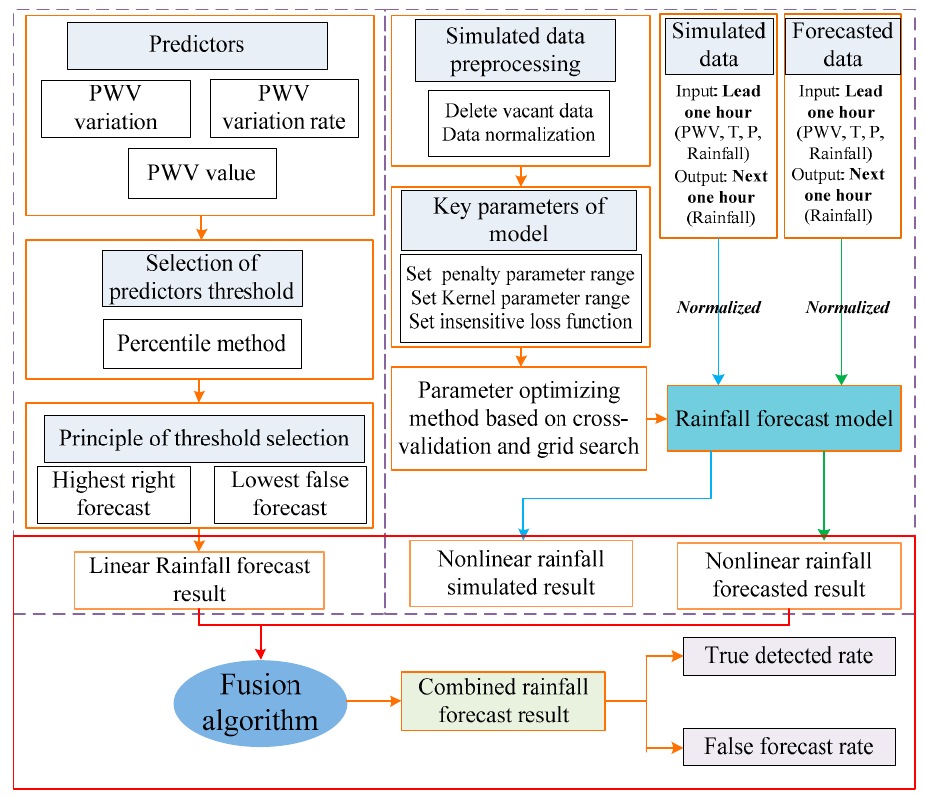
Figure 2. Experimental design route for the combined linear–nonlinear rainfall forecast model.